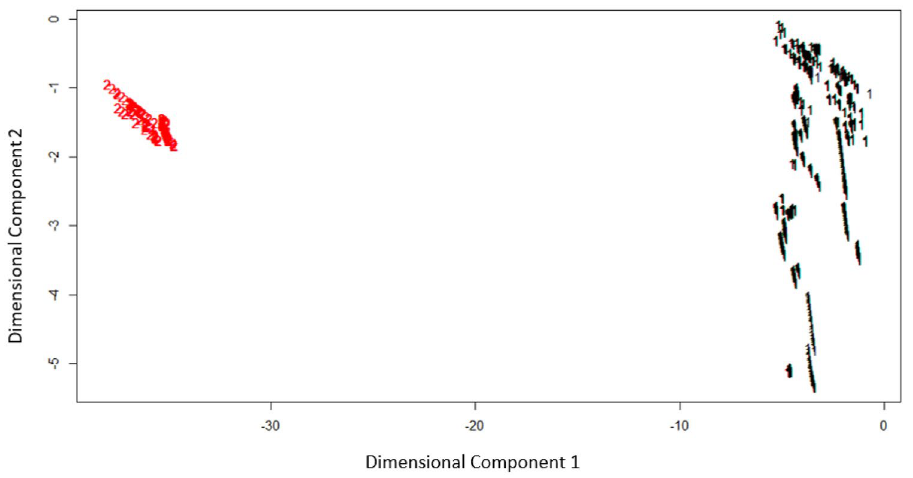
Figure 3. Cluster patterns of Fuzzy K-means and